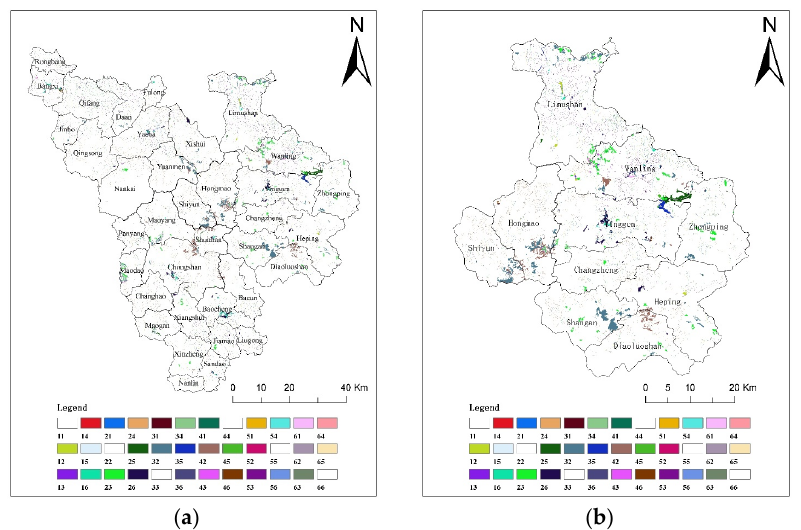
Figure 3. Land-use change from 2000 to 2018. ( a ) CMA ( b ) Qiongzhong (1—cultivated land; 2—